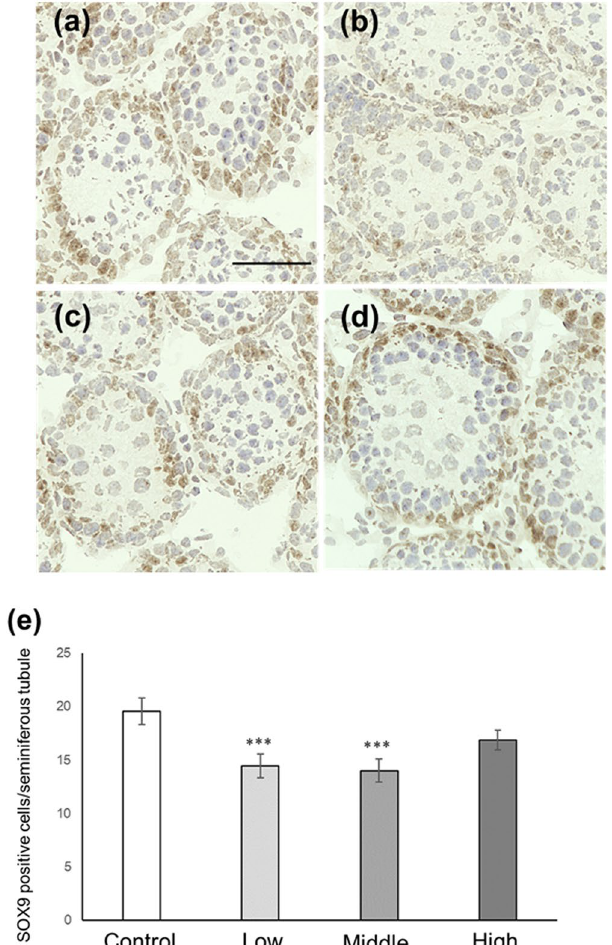
Figure 9. Number of SOX-9-positive Sertoli cells in CORT-administered mice on PND 16. Representative micrographs of Sertoli cells immunostained with anti-GATA-1 antibody in the testes from control ( a ), low- dosed ( b ), middle-dosed ( c ), and high-dosed-CORT mice ( d ) on PND 16. The scale bar is 50 µm. SOX-9- positive cells per seminiferous tubule among the control and CORT mice ( e ). Values are expressed as the mean ± S.E.M of data from 10 animals per group (10 seminiferous tubules per animal). ***p < 0.001 compared to the